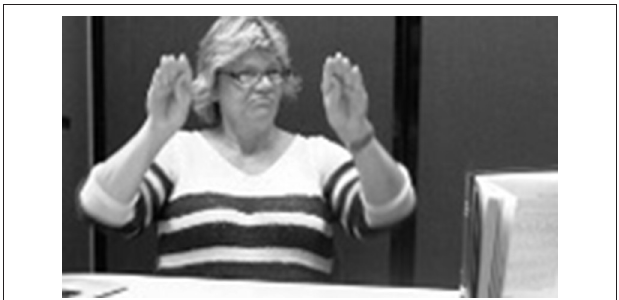
FIGURE 3 | Handling classifier representing an agent holding a tablecloth.